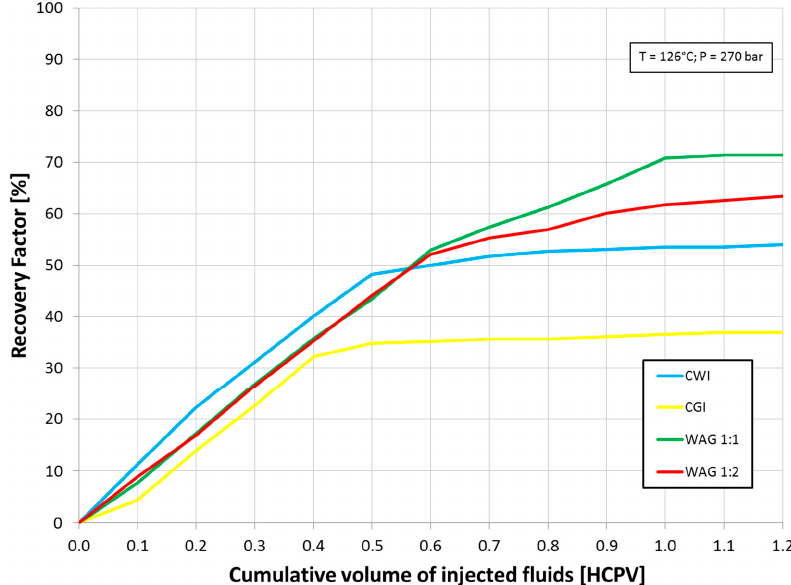
ffi ciency of oil recovery using di ff erent methods of injection for non-fractured Figure 6. The efficiency of oil recovery using different methods of injection for non-fractured cores. Figure 6. The e